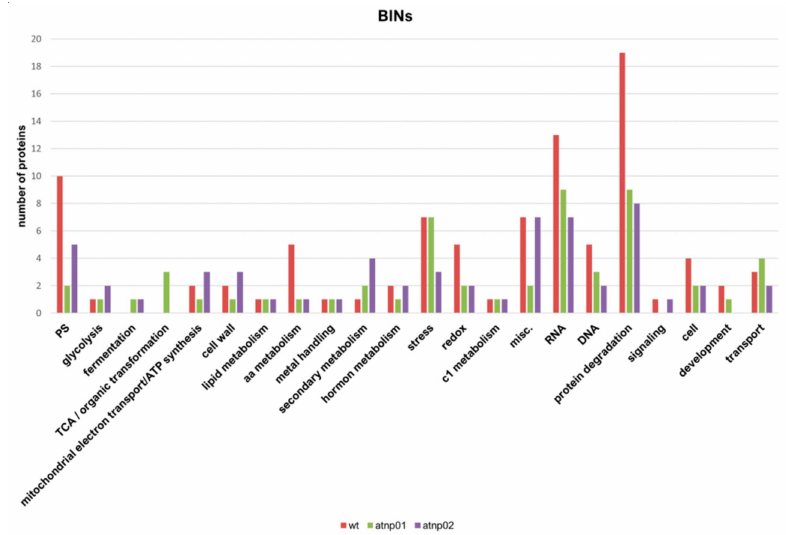
Figure 3. The distribution of differentially abundant proteins in wt, atnp01 and atnp02 according to MapMan ontology classification (BINs). The horizontal axis shows the different MapMan bin types, with the number of proteins for each bin on the vertical